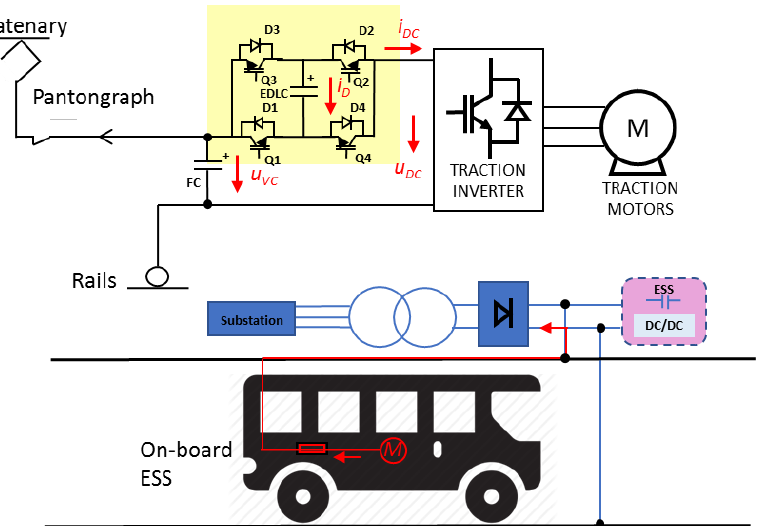
Figure 7. Topology of onboard-wayside supercapacitor hybrid energy storage system extracted adapted from [32].